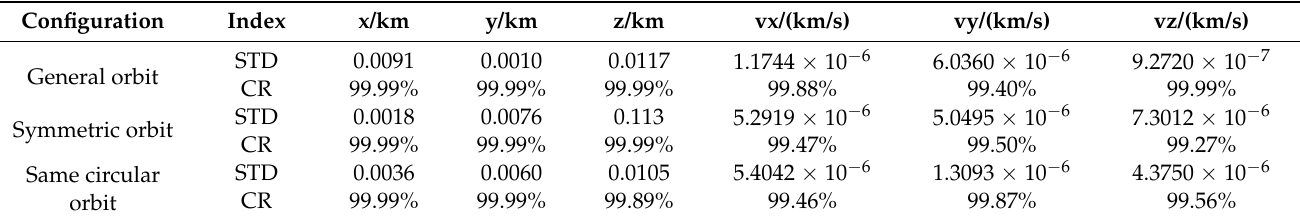
Figure 9. Errors of orbit elements in general case. Table 8. Final STD and CR results for the cooperative OD with an additional observer.